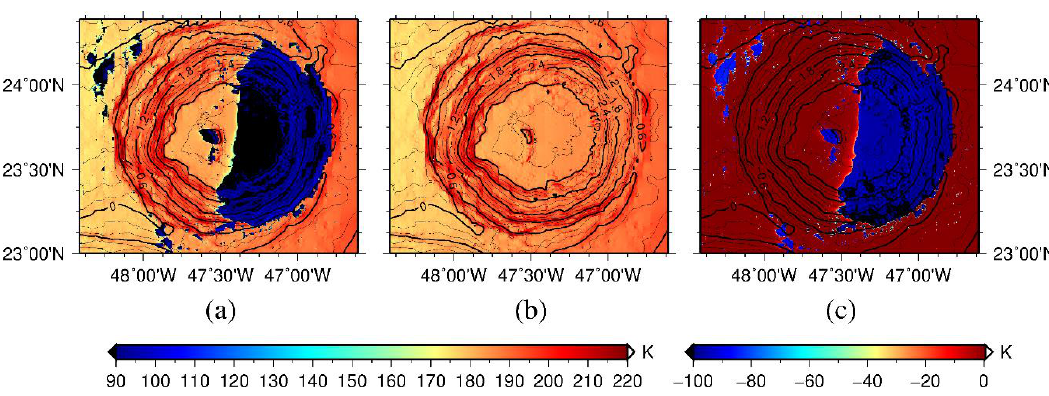
Figure 4. The surface temperature over Aritarchus with ( a ) and without ( b ) terrain obscuration, and their residual ( c ) at the lunar local time t m = 6:39:31.